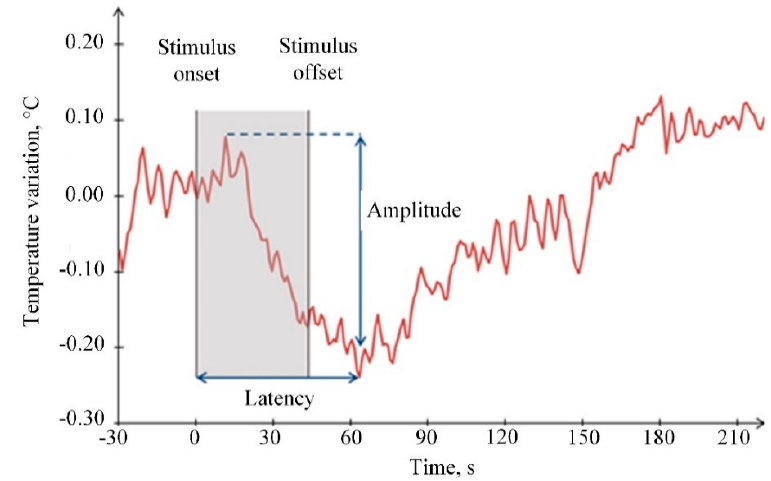
Figure 10. Example of skin temperature change due to applied stimulus [127].